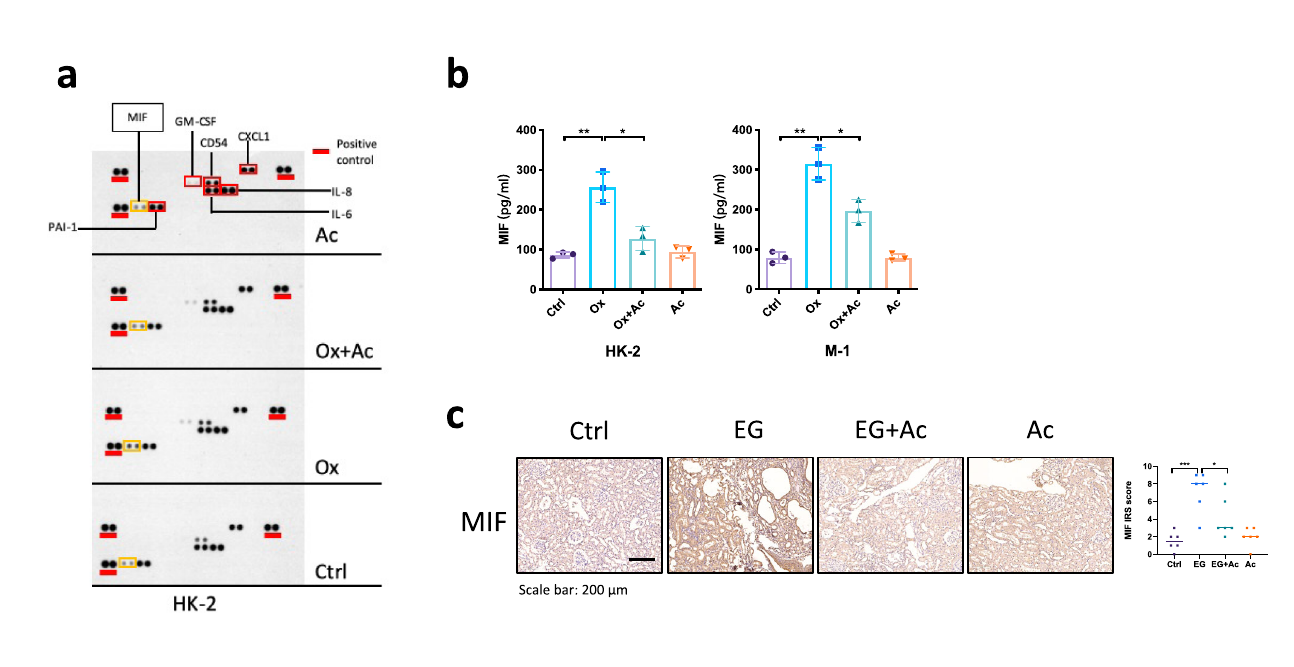
Fig. 2 Acetate decreases oxalate-induced renal tubular cell injury via inhibiting macrophage in fi ltration. a In co-culture system 4 groups were established, including Ctrl (control) — renal tubular cells cultivated in normal culture medium, Ox (Oxalate) — renal tubular cells cultivated in culture medium containing 0.5 mM oxalate, Ox + M Φ — renal tubular cells co-cultured with macrophages in culture medium containing 0.5 mM oxalate, M Φ — renal tubular cells co-cultured with macrophages in normal culture medium. b Lactate dehydrogenase (LDH) release measurement in renal tubular cells co- cultured with macrophages in 0.5 mM oxalate condition. c The Q-PCR analysis of in fl ammation-related gene expression in renal tubular cells co-cultured with macrophages in 0.5 mM oxalate condition. d Experimental outline for macrophages recruitment assay. The conditioned medium (CM) were collected from renal tubular cells treated with oxalate and/or acetate for 24 h. For macrophage recruitment assay, 1 × 10 5 /well M Φ s were added in the upper chambers, and the CM were placed into the lower chambers of transwell plates. e Macrophage recruitment to the normal culture medium without renal tubular cells. f The macrophages recruitment to CM from renal tubular cells treated with/without acetate were shown. n = 3 for each group * P < 0.05, ** P < 0.01. # P < 0.05 compared with Ox group.